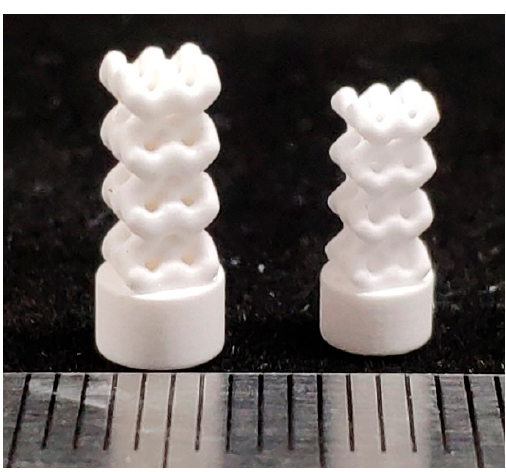
Figure 9. BI002 model specimens after printing ( left ) and after sintering ( right ).